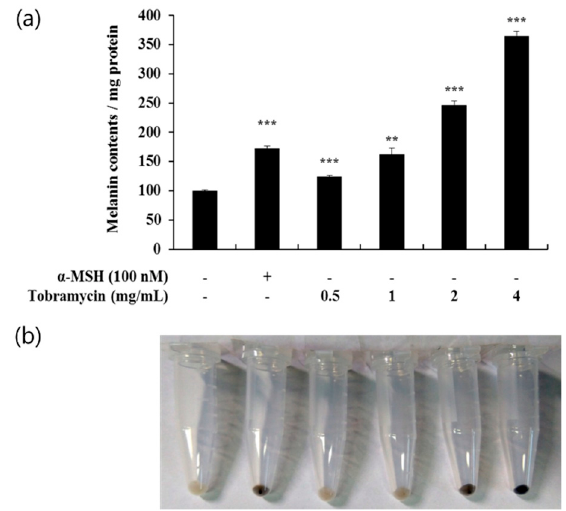
Figure 3. Melanin levels in tobramycin-treated B16F10 melanoma cells. The cells were treated with various concentrations of tobramycin for 72 h, and α -MSH was used as a positive control. ( a ) Melanin concentrations are expressed as percentages compared to the respective values obtained for the control cells. ( b ) Images of corresponding B16F10 cell pellets harvested by centrifugation. Data are presented as mean ± standard deviation (SD) of at least four independent experiments ( n = 4). *** indicates p < 0.001 vs. untreated cells.